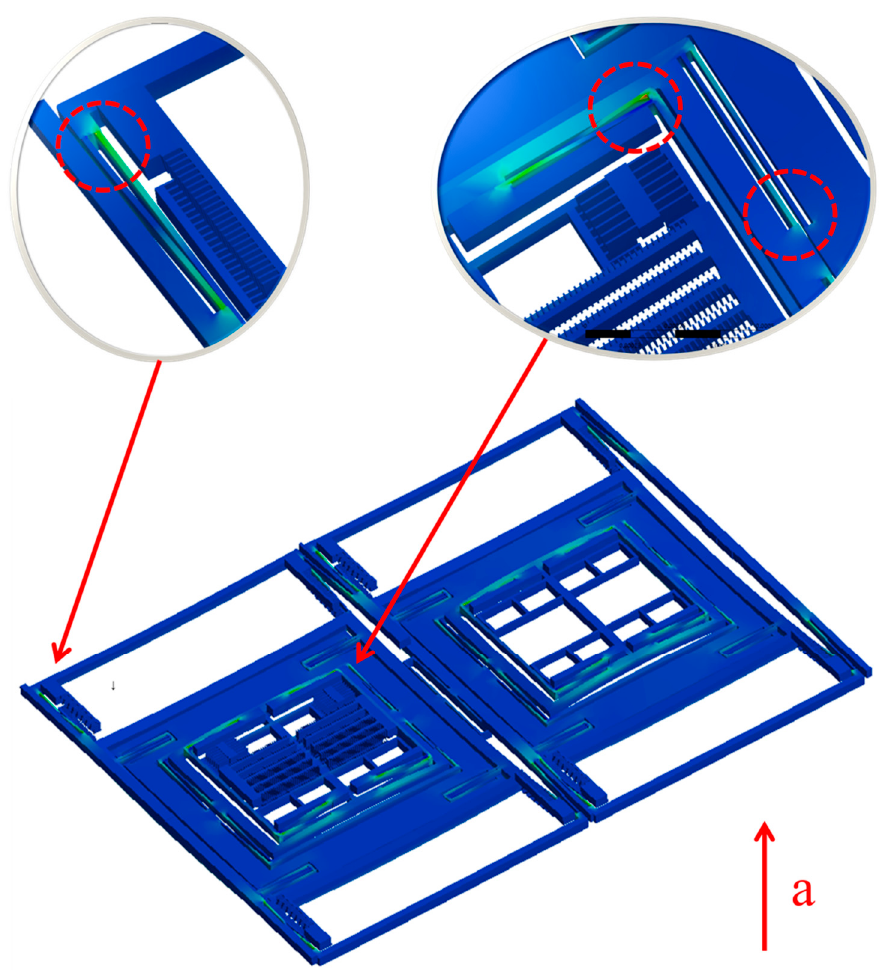
Figure 9. Deformation and weak positions under the impact of Shock Pulse 1 (the red arrows with ‘a’ indicate the direction of shock impact relative to the MEMS tuning fork gyroscope).